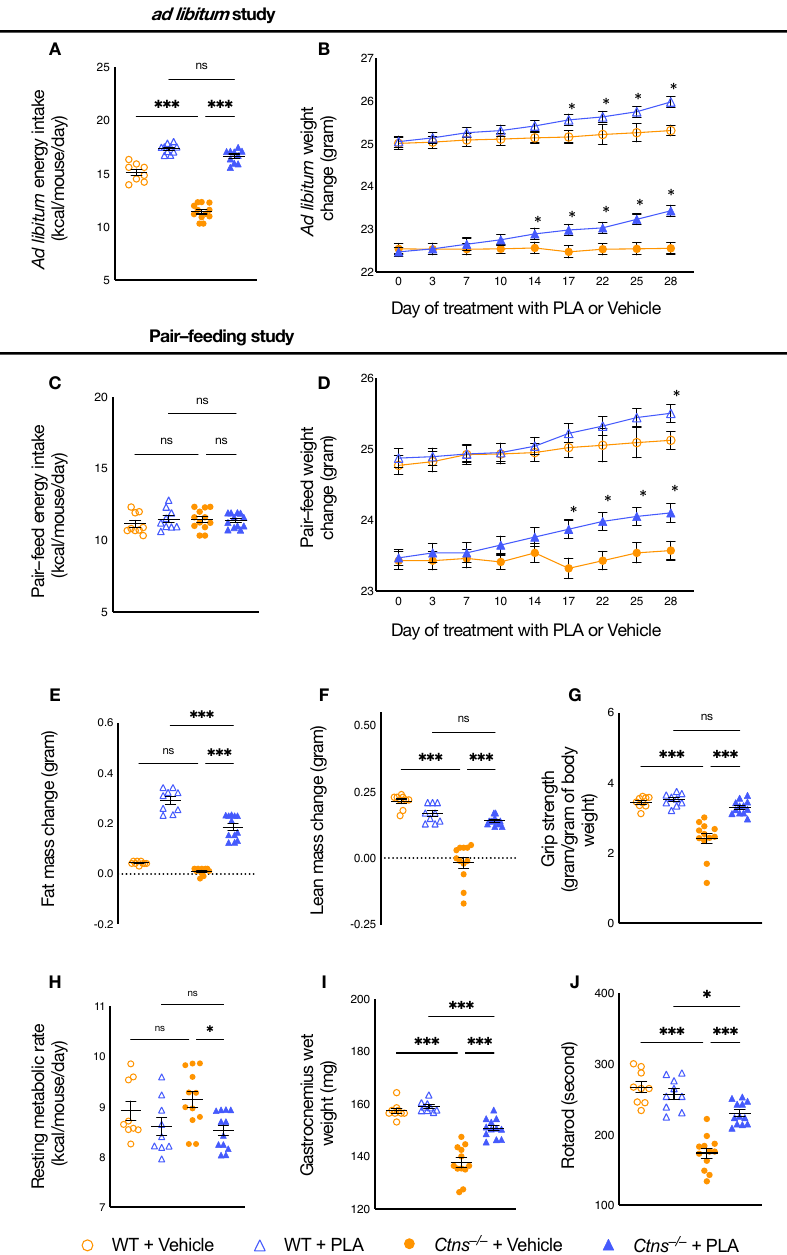
Figure 1. PLA attenuates cachexia in Ctns −/− mice. We have performed the following two studies. Ctns − / − and WT mice were given PLA (7 mg/kg/day, IP) or vehicle (normal saline), respectively. The study period was 28 days and all mice were fed ad libitum . We calculated ad libitum caloric intake ( A ) and recorded weight change in mice ( B ). In another experiment, to assess the beneficial effects of PLA beyond its nutritional effects, we employed a pair-feeding strategy. Ctns −/− and WT mice were given PLA (7 mg/kg/day, IP) or vehicle (normal saline) for 28 days. Vehicle-treated Ctns −/− mice were given an ad libitum amount of food whereas other groups of mice were given an equivalent amount of food ( C ). Weight gain, fat and lean content, resting metabolic rate (RME), left gastrocnemius wet weight and in vivo muscle function (grip strength and rotarod) were measured in mice ( D – J ). Data are expressed as mean ± SEM. For weight change in mice ( B , D ), results of vehicle-treated WT mice were compared to PLA-treated WT mice while vehicle-treated Ctns − / − mice were compared to PLA-treated Ctns − / − mice. For other data ( A , C , E – J ), results of vehicle-treated Ctns − / − mice were compared to vehicle-treated WT mice while results of PLA-treated Ctns − / − mice were compared to those of PLA-treated WT mice. In addition, results of PLA-treated Ctns − / − mice were compared to vehicle-treated Ctns − / − mice and specific p -values are shown above the bar. ns signifies not significant, * p < 0.05, *** p <